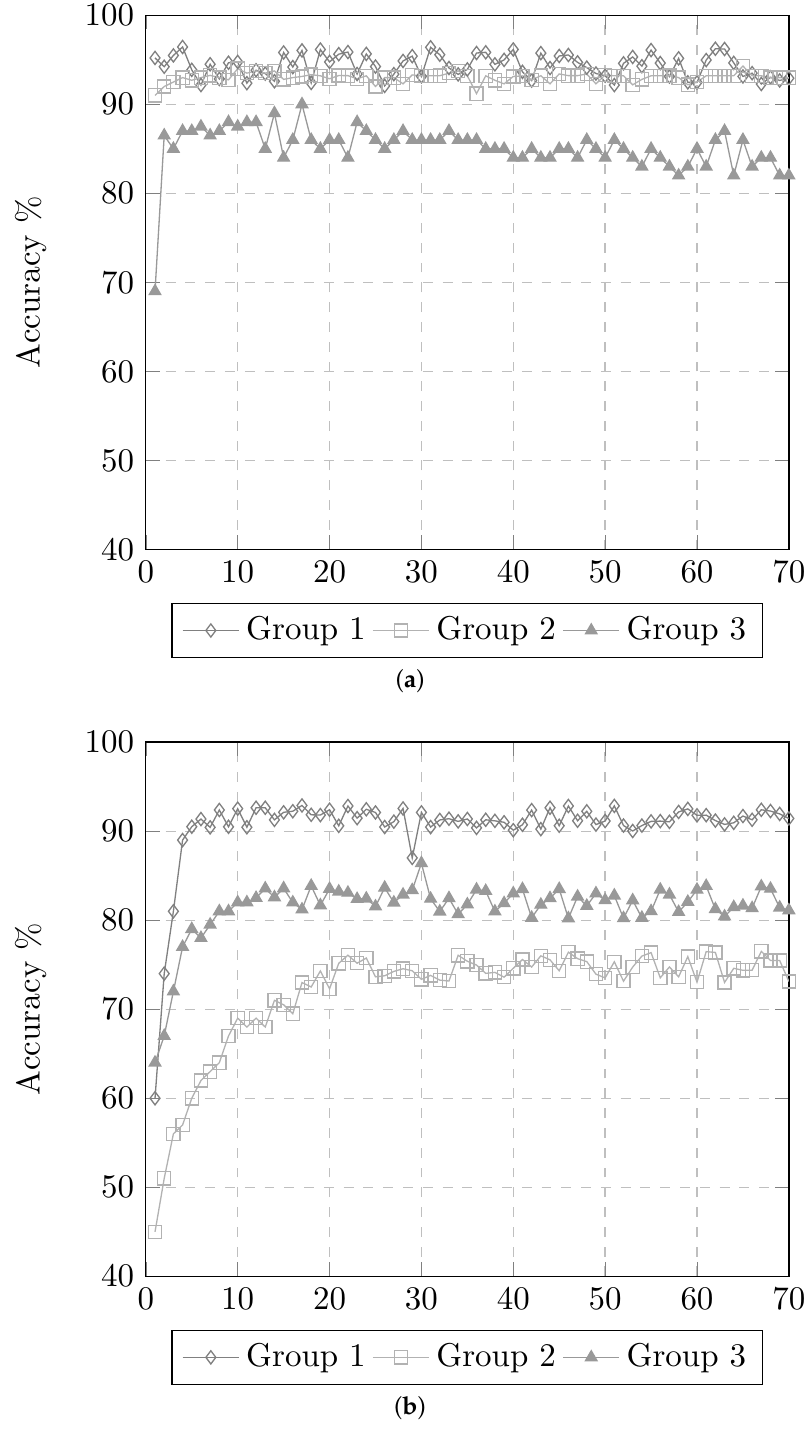
Figure 14. Accuracies obtained for three wide classes when the number of neurons in the hidden layer is varied. ( a ) Phase 1 classification. ( b ) Phase 2